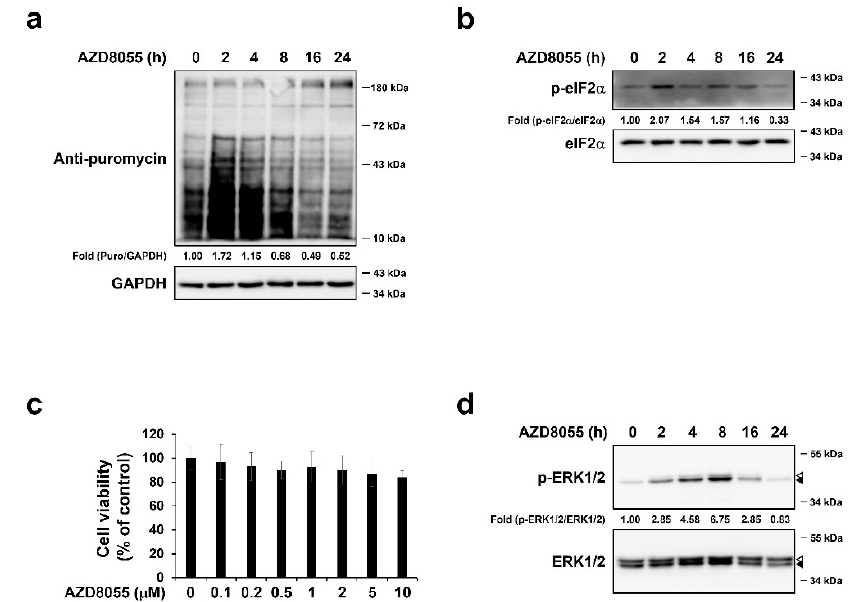
Figure 2. AZD8055 inhibits protein synthesis and up-regulates phosphorylation of ERK1/2 in hepatocellular carcinoma HepG2 cells. ( a , b ) HepG2 cells were treated with 2 µ M AZD8055 for the indicated periods. Cells were pulse-labeled with puromycin for 10 min and immunoblot analyses were performed. The relative levels of puromycin and p-eIF2 α were normalized using GAPDH ( a ) and eIF2 α ( b ), respectively. ( c ) MTT assay was performed to measure viability of cells treated with various concentrations of AZD8055 for 24 h. The data obtained from three independent experiments were presented as means ± S.D. ( d ) HepG2 cells were treated with 2 µ M AZD8055 for 2–24 h and immunoblot analyses were performed using specific antibodies for ERK1/2 and phosphorylated form of ERK1/2 (p-ERK1/2). Open arrowheads and closed arrowheads indicate ERK1 and ERK2,